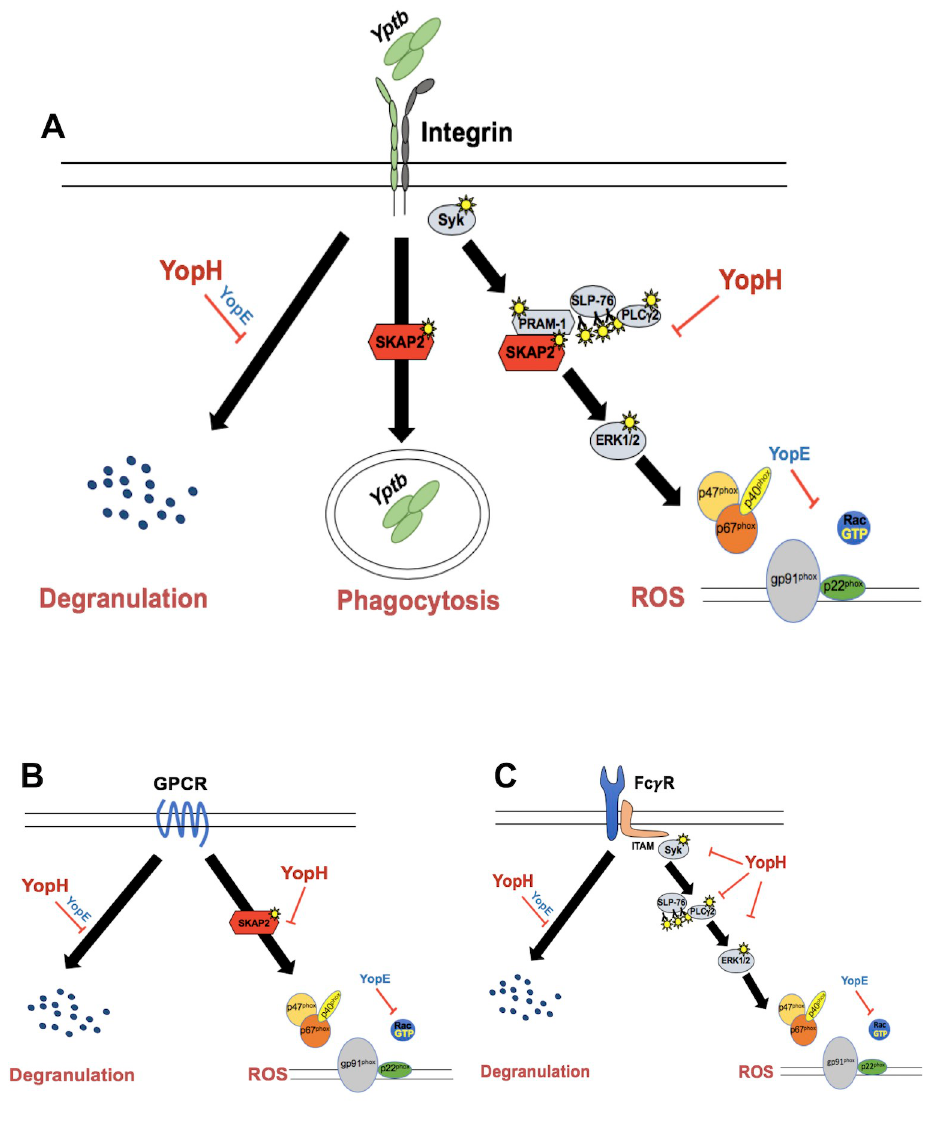
Fig 8. YopH dephosphorylates SKAP2-dependent and independent signaling proteins inhibiting ROS production and degranulation in neutrophils. (A) After integrin engagement, YopH inhibits signal propagation that is required for the activation of the NADPH oxidase complex and degranulation while SKAP2 is essential for ROS and phagocytosis and for maximal ERK1/2 phosphorylation, but not for degranulation or phosphorylation of Syk, SLP-76 and PLC γ 2. (B) After GPCR stimulation of LPS-primed neutrophils with fMLP, YopH inhibits ROS and degranulation, where SKAP2 is required for ROS production, but not degranulation. (C) YopH inhibits ROS and degranulation after Fc γ R stimulation and reduces phosphorylation of Syk, SLP-76, PLC γ 2 and ERK1/2, but SKAP2 is not required for ROS production, degranulation, nor phosphorylation of these signaling proteins. molecule in secondary granules [40, 41]. Interestingly, infecting neutrophils with a Δ 5 mutant induced a significantly higher MMP-9 release than the activation of a single receptor with its corresponding ligand (S6B Fig). These results suggest concurrent stimulation of several recep- tors during infection can occur, which results in activation of multiple signaling pathways to effectively magnify the response. This may occur in a tissue infection milieu where neutrophils